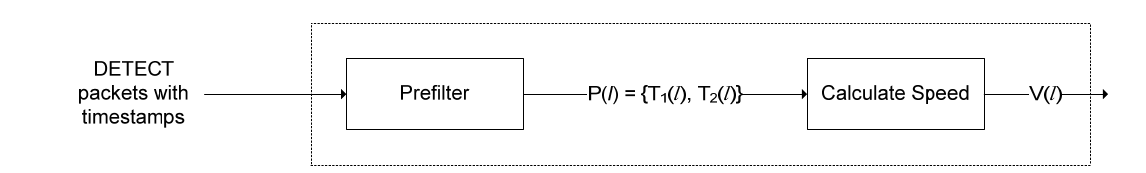
Figure 6. Speed measurement Algorithm block diagram.